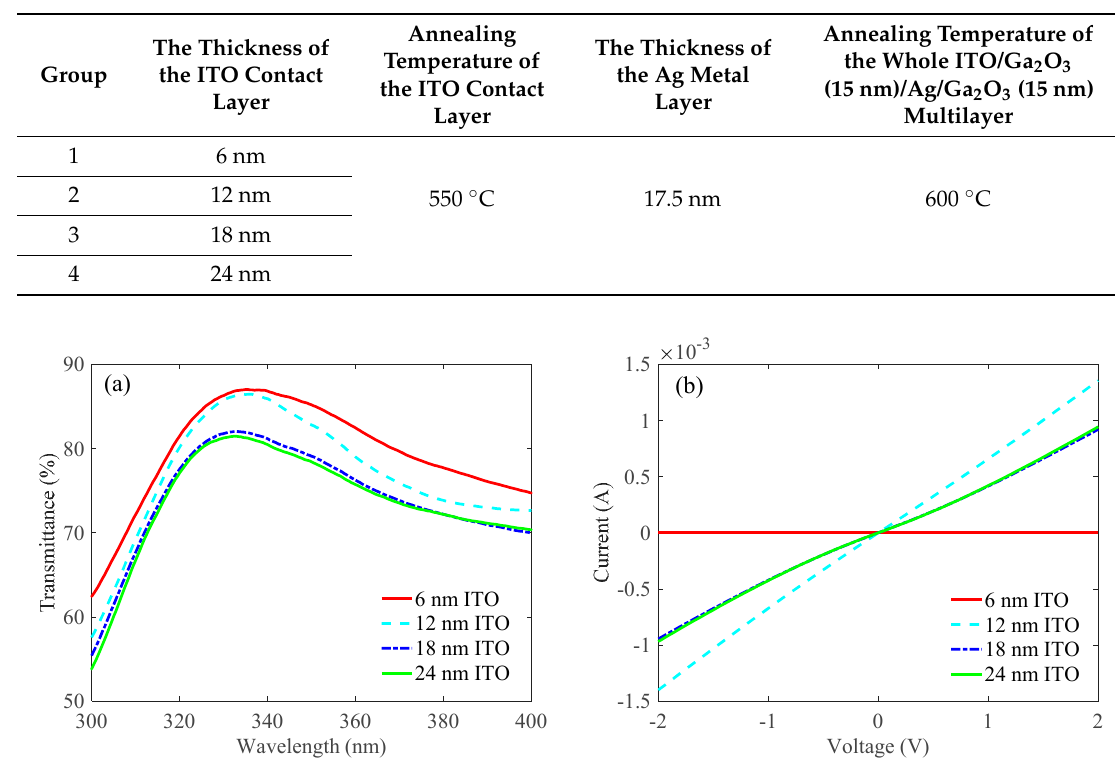
Figure 4. Effects of the thickness of the ITO contact layer on ( a ) transmittances and ( b ) I - V characteristic curves of the ITO/Ga 2 O 3 /Ag/Ga 2 O 3 multilayer when the thickness of the Ag metal layer was 17.5 nm and the annealing temperature of the ITO contact layer and the whole ITO/Ga 2 O 3 /Ag/Ga 2 O 3 multilayer were 550 °C and 600 °C, respectively.